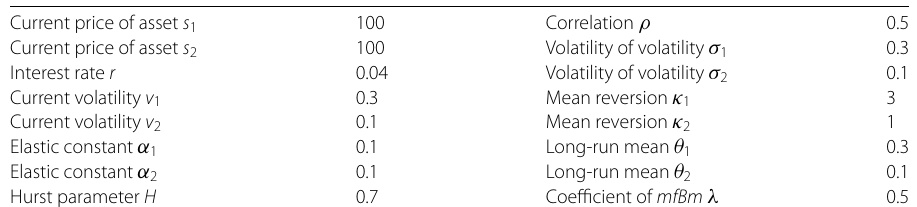
Table 1 Parameters used for simulation Current price of asset s